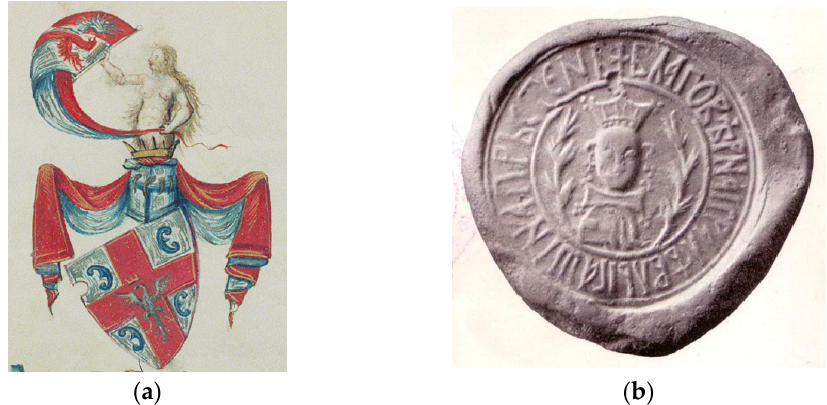
Figure 3. ( a ) Mrnjavcevic coat of arms (London Armorial); ( b ) Volkashin seal from charter of 1370